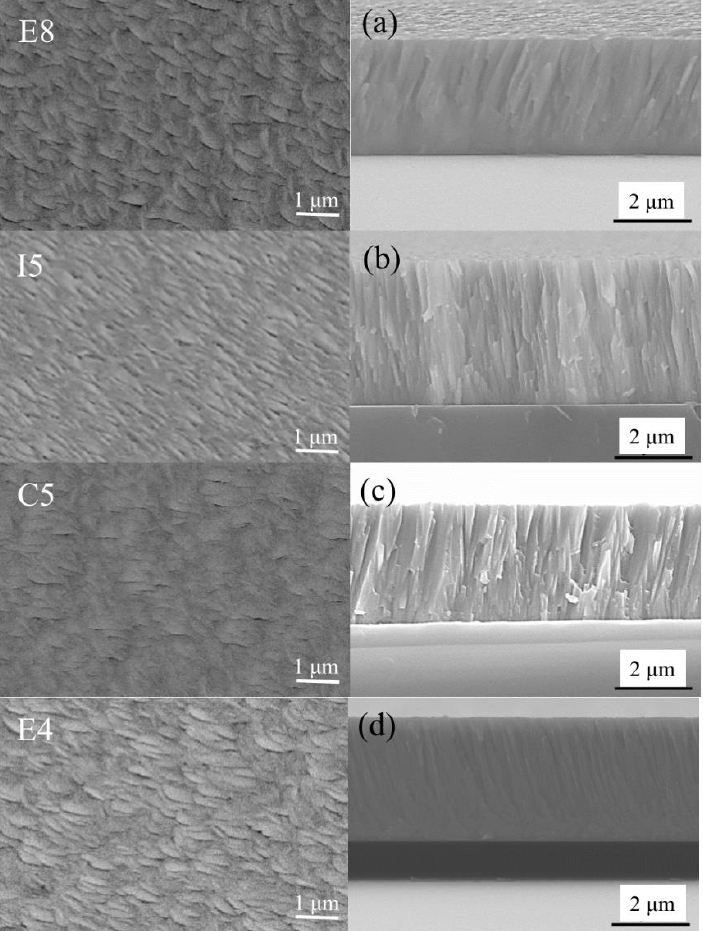
Figure 7. SEM plan-view morphology and cross-sectional of ZrMoTaW RMPEA thin films: E8, ( a ) Table 6. Mean grain size, thickness, and deposition rate of ZrMoTaW RMPEA thin films.